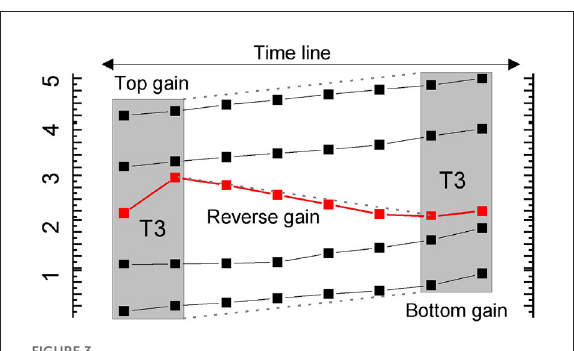
FIGURE3 Social organization project contact person’s license status